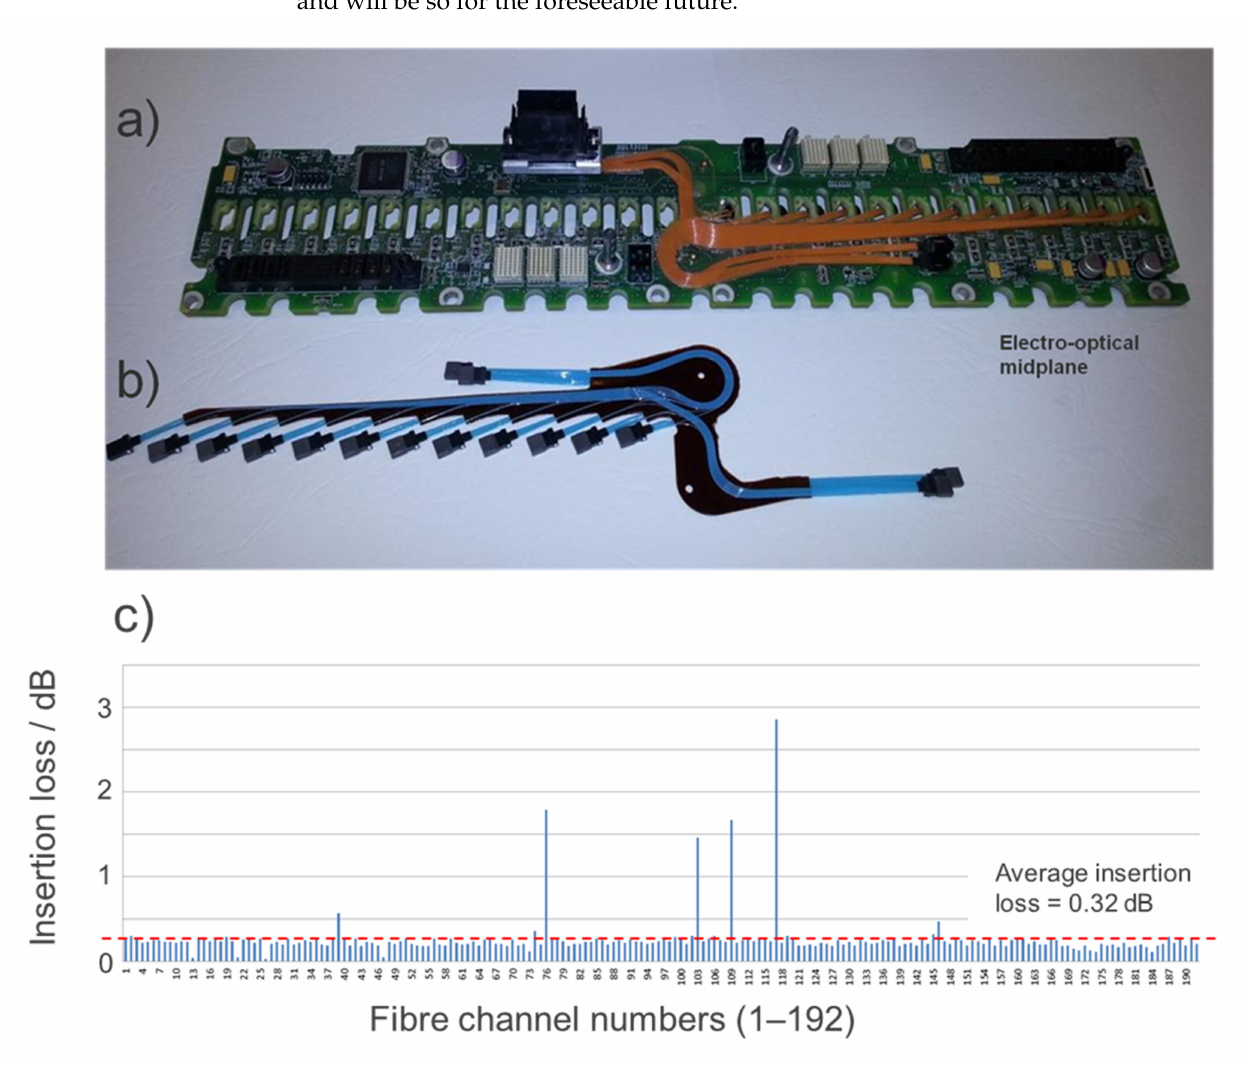
Figure 9. Electro-optical midplane for data storage array: ( a ) electro-optical midplane with only right-hand fiber flexplane populated [5,12], ( b ) left-hand fiber flexplane with 92 fibers [5,12], ( c ) optical link performance of fiber